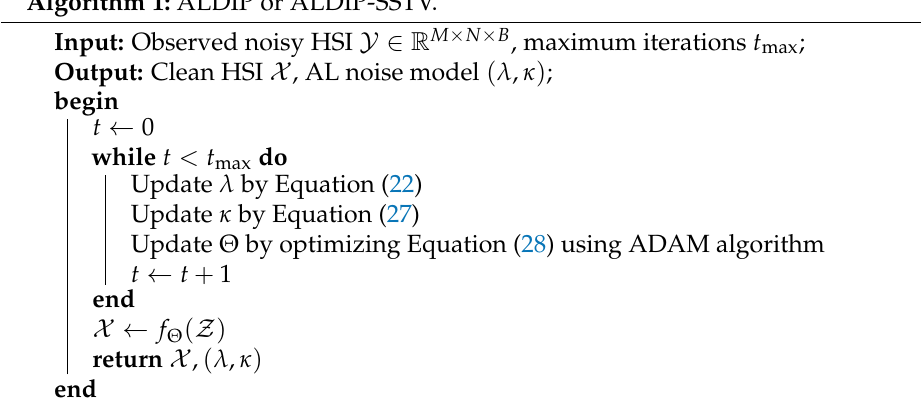
Algorithm 1: ALDIP or